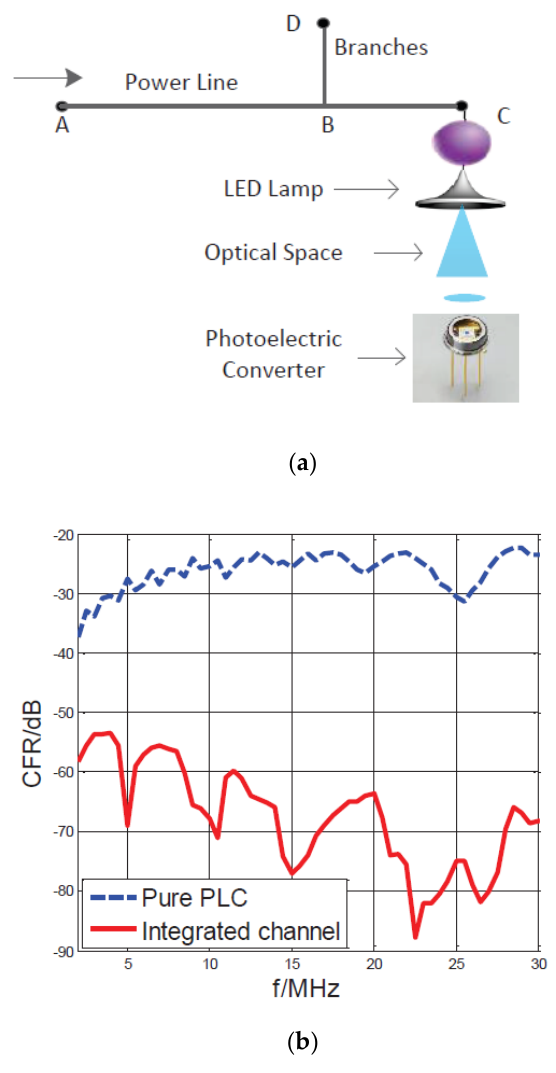
Figure 6. The integrated PLC and IWOC: ( a ) Channel structure of the integrated PLC and IWOC; ( b ) measured pure PLC channel and integrated channel [25].